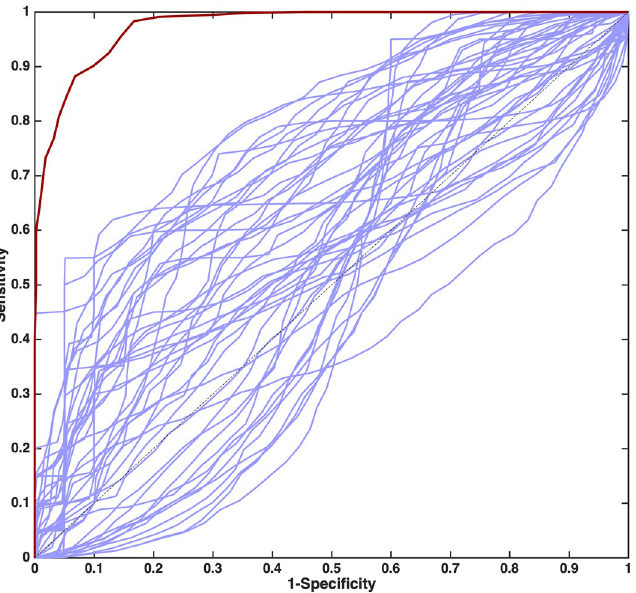
Figure 6. Receiver operating characteristic (ROC) curve for the PLS-DA model calculated on the ESI− data set (dark red line) and for the individual metabolites (blue lines). Each curve is the mean of the 50 curves obtained on the outer loop samples in